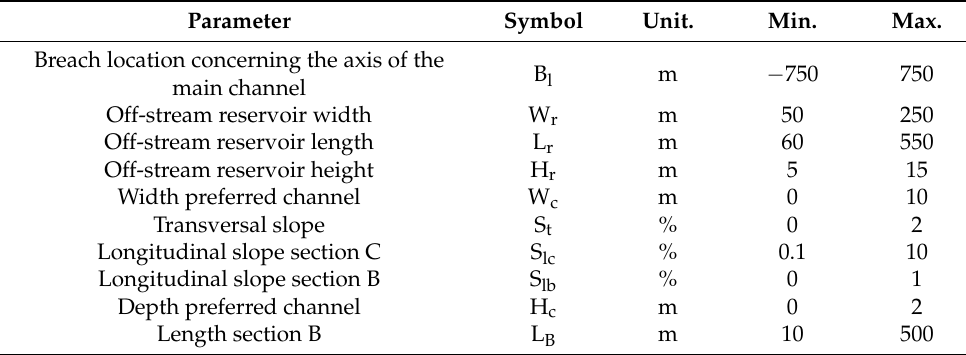
Table 1. Geometry parameters and ranges of